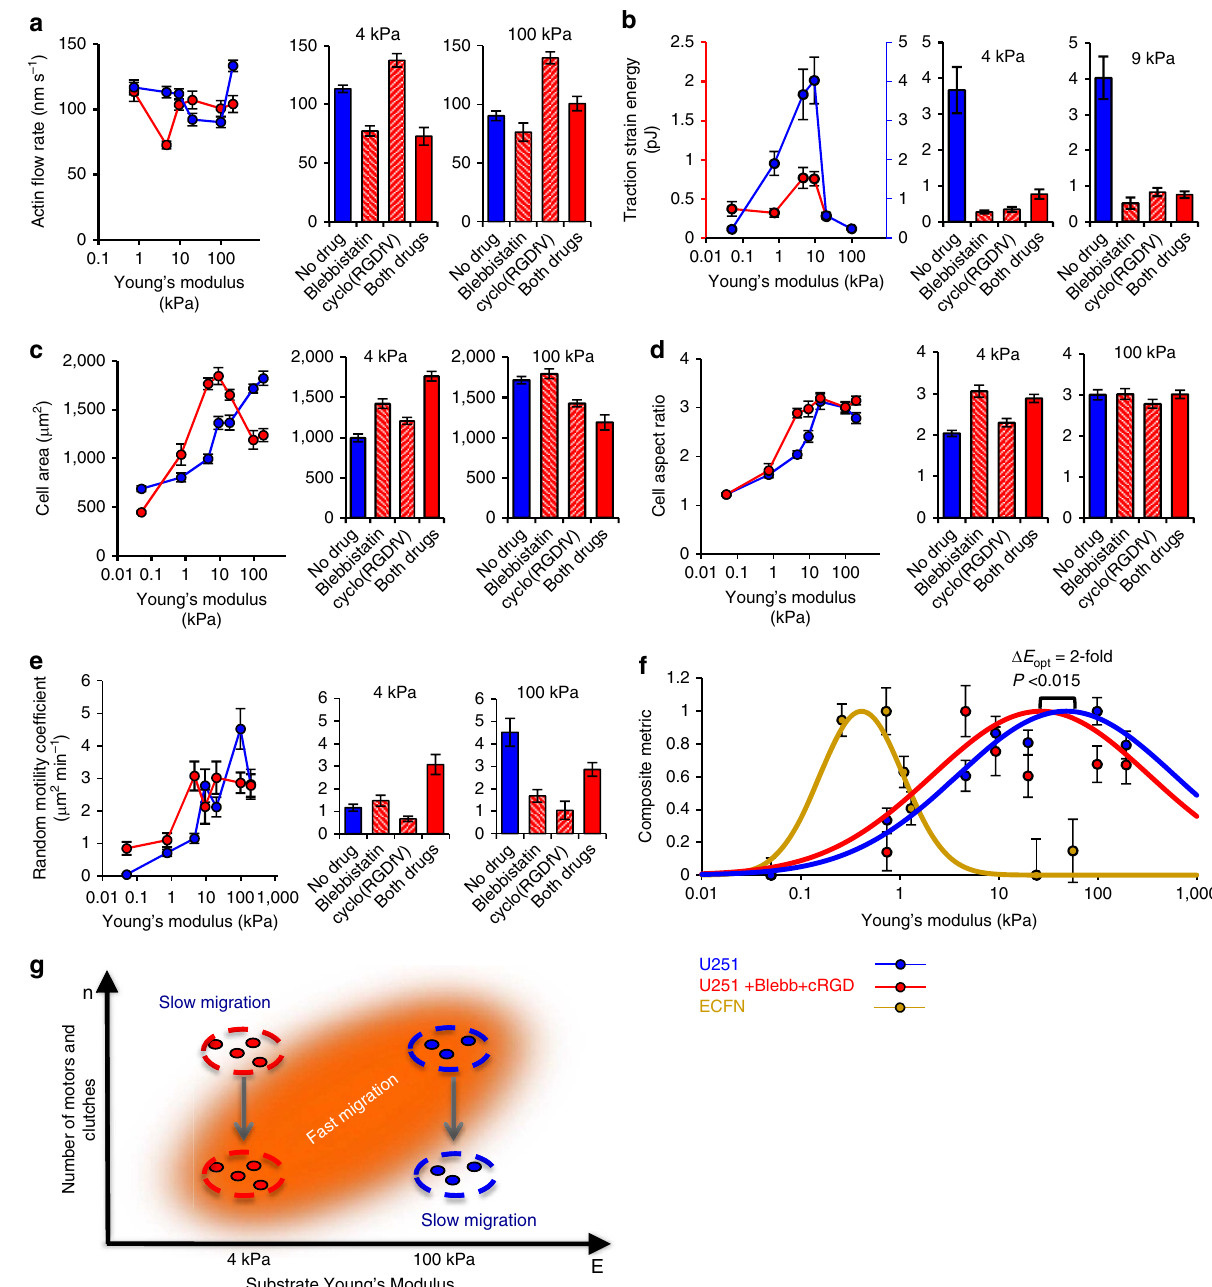
Figure 4 | Simultaneous inhibition of motors and clutches shifts the optimum stiffness to lower Young’s modulus. ( a ) Addition of both drugs shifted the minimum actin flow rate to B 4.6kPa. cylco(RGDfV) alone increased actin flow on both 4.6 and 100kPa, while blebbistatin alone reduced actin flow on 4.6kPa but not significantly on 100kPa. The combined drug treatment reduced actin flow on 4.6kPa but did not significantly affect actin flow on 100kPa. ( b ) Addition of both drugs decreased traction strain energy by approximately fourfold on all stiffnesses. The maximum traction strain energy maintained its maximum at B 9kPa. However, the combined drug treatment increased the traction strain energy compared with either individual drug treatment on 4.6kPa. ( c ) Addition of both drugs caused the maximum area to be B 9kPa. On 4.6kPa, the addition of both drugs increased the cell area, while on 100kPa they decreased the cell area. ( d ) Addition of both drugs did not shift the maximum aspect ratio. On 4.6kPa, blebbistatin individually and both drugs combined increase the aspect ratio. None of the drugged cases had a significant effect on the aspect ratio on 100kPa. ( e ) Simultaneous addition of 6 m M blebbistatin and 0.6 m M cyclo(RGDfV) shifts the potential maximum U251 glioma cell random motility coefficient to B 4.6kPa. On 4.6kPa, addition of both drugs increases the random motility coefficient compared with the no drug, blebbistatin and cylco(RGDfV) cases. On 100kPa, all three drugged cases are lower than the no drug case, but addition of both drugs increases the random motility coefficient compared with either single drug case. ( f ) A composite metric with corresponding Gaussian fit curves demonstrates the shifting in stiffness optimum among U251 glioma cells, U251 glioma cells treated with blebbistatin and cyclo(RGDfV) and ECFNs. Gaussian fit curves peaks show a statistically significant shift in the optimum stiffness for the untreated and treated U251 glioma cell composite metric ( P ¼ 0.015). ( g ) Illustration of how same drug treatment may result in opposite effects in different mechanical environments. P values for all bar chart comparisons are presented in Supplementary Table 4. All error bars are s.e.m. The number of observations for each experiment can be found in Supplementary Table